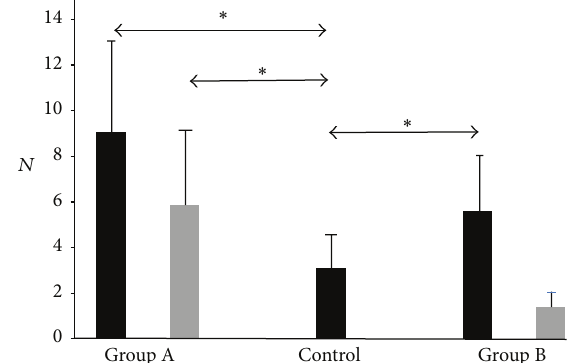
Figure 2: 𝑁 findings graphically. Asterisks denote statistical signifi- cance. Preoperative bars are black and postoperative bars are grey. Vertical axis depicts number of excitable positions where MEP is elicited ( 𝑁 ). Horizontal axis depicts patient and control